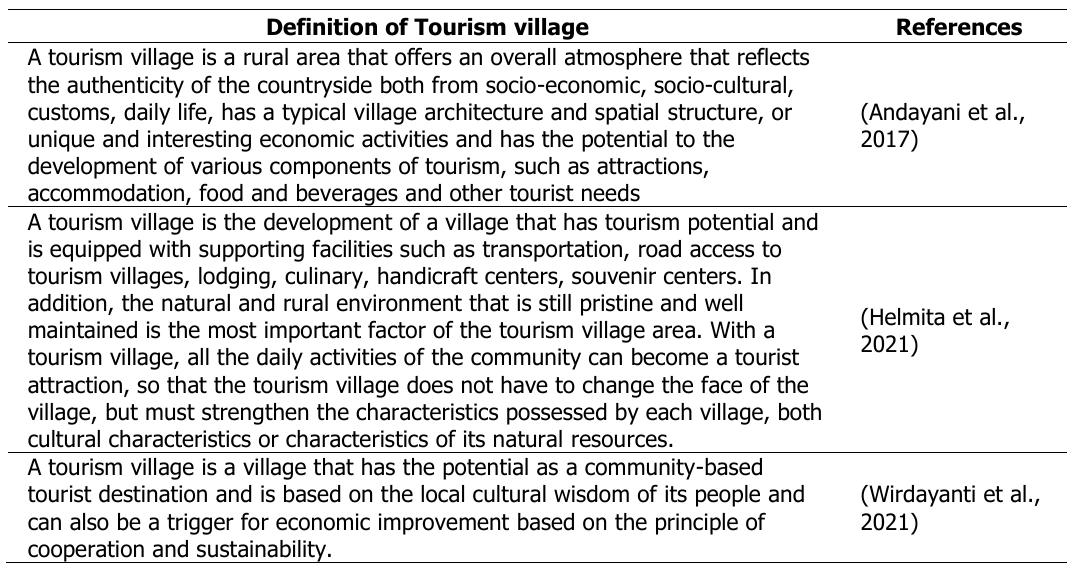
Table 1. Comparison Of The Concept Of Tourism